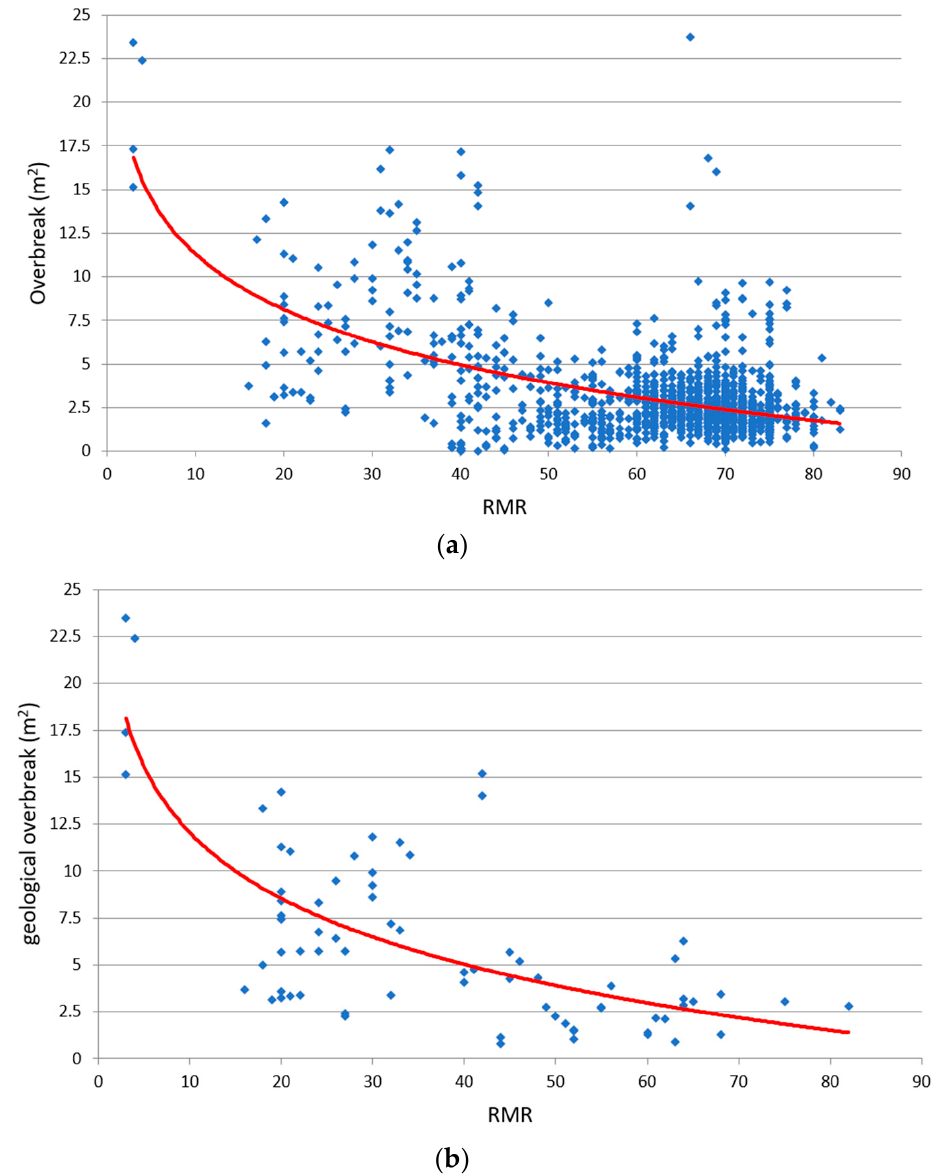
Figure 11. Measured overbreaks (m 2 ) depending on RMR value for ( a ) all analysed data (1601 pieces of data) and ( b ) data for which geological overbreaks were confirmed by mapping (72 pieces of data).